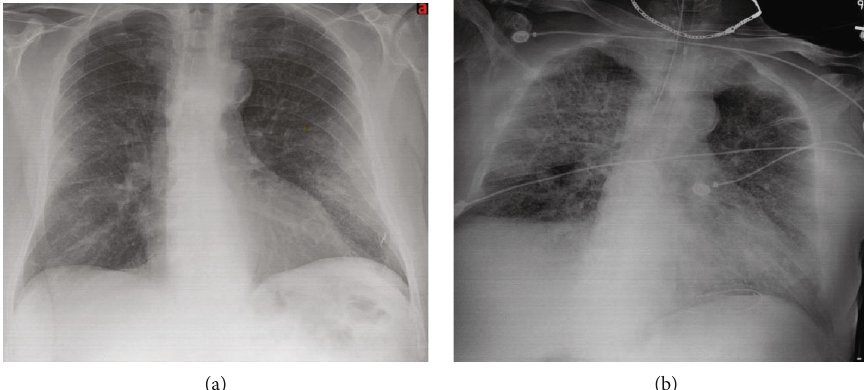
Figure 1: (a) CXR shows bilateral peripheral in fi ltrates. (b) Repeat CXR after 48 hrs demonstrating progressive lung in fi